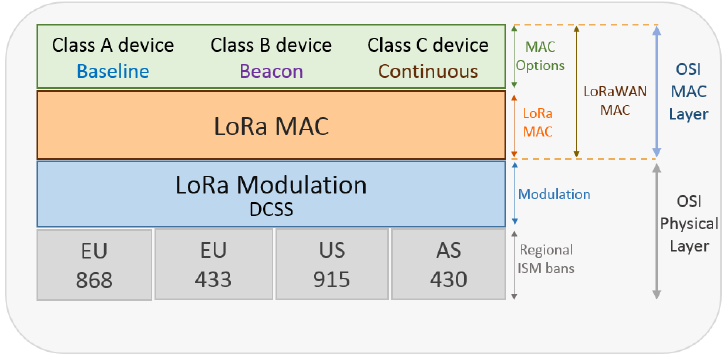
Figure 22. LoRa and LoRaWAN protocol